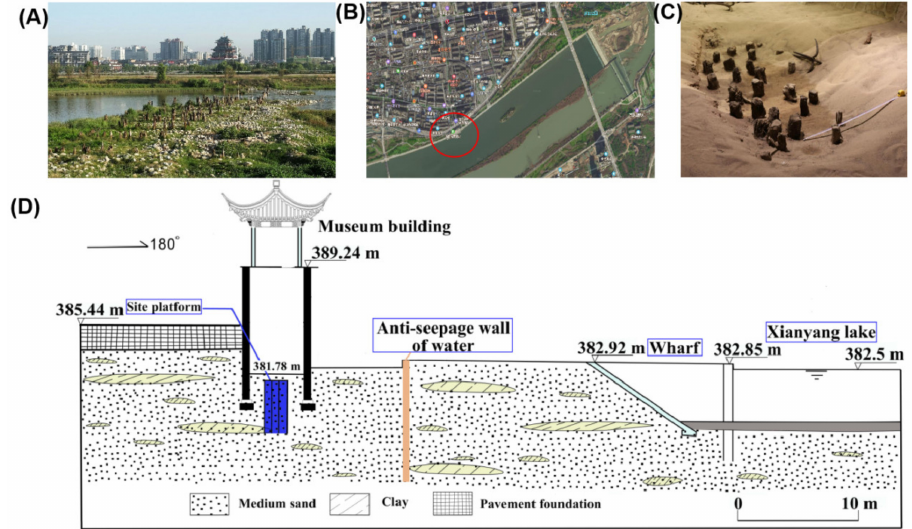
Figure 2. Occurrence conditions of Gudu ruins. ( A ): excavated photos of the Gudu ruins; ( B ): geo- morphology around the Gudu ruins; ( C ): site photos of the Gudu ruins; ( D ): geological section of Gudu ruins